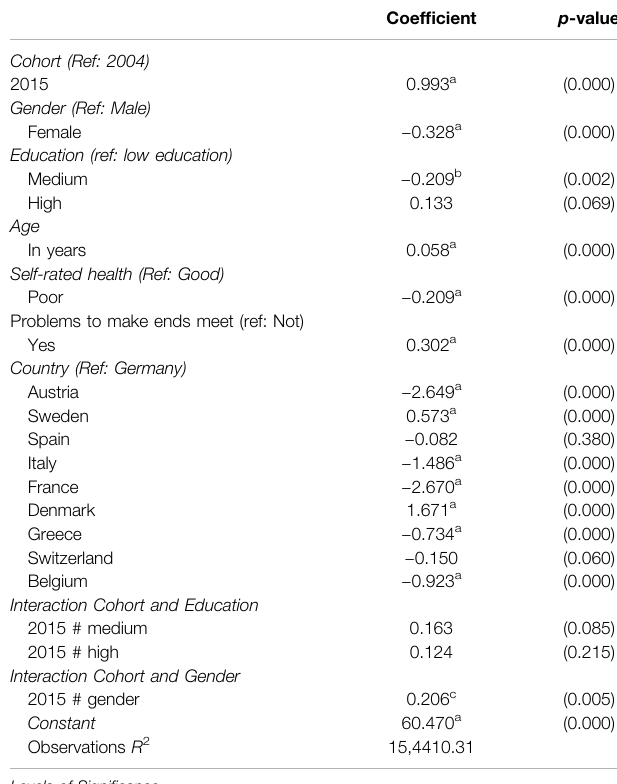
TABLE 2 | Overview of planned retirement age country values. TABLE 3 | Linear regressions with planned retirement age as dependent